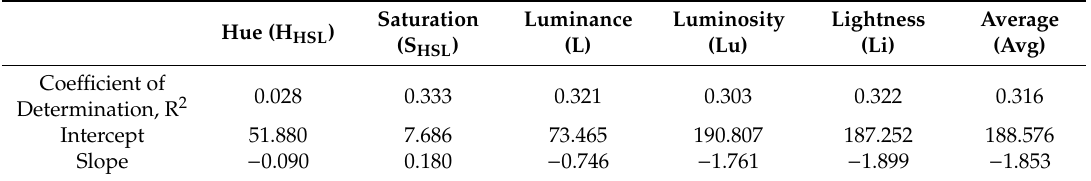
Table 2. Linear regression parameter between H HSL , S HSL , L, Lu, Li, Avg and PM 10 concentrations for all samples collected in Badajoz and Monfragüe during 2015. Hue (H HSL